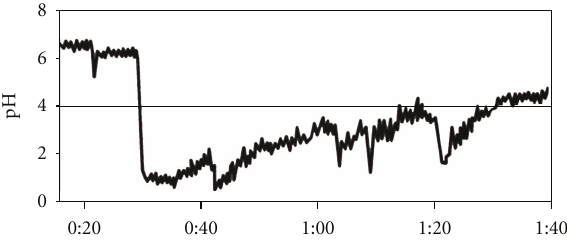
Figure 1: Pattern of sleep-related esophageal acid exposure in a patient with erosive esophagitis. Night-time acid reflux during supine sleep leads to pH levels < 4 that are continuous and sustained. (Reproduced Figure 2, page 111S, from Orr [26]. With copyright permission from